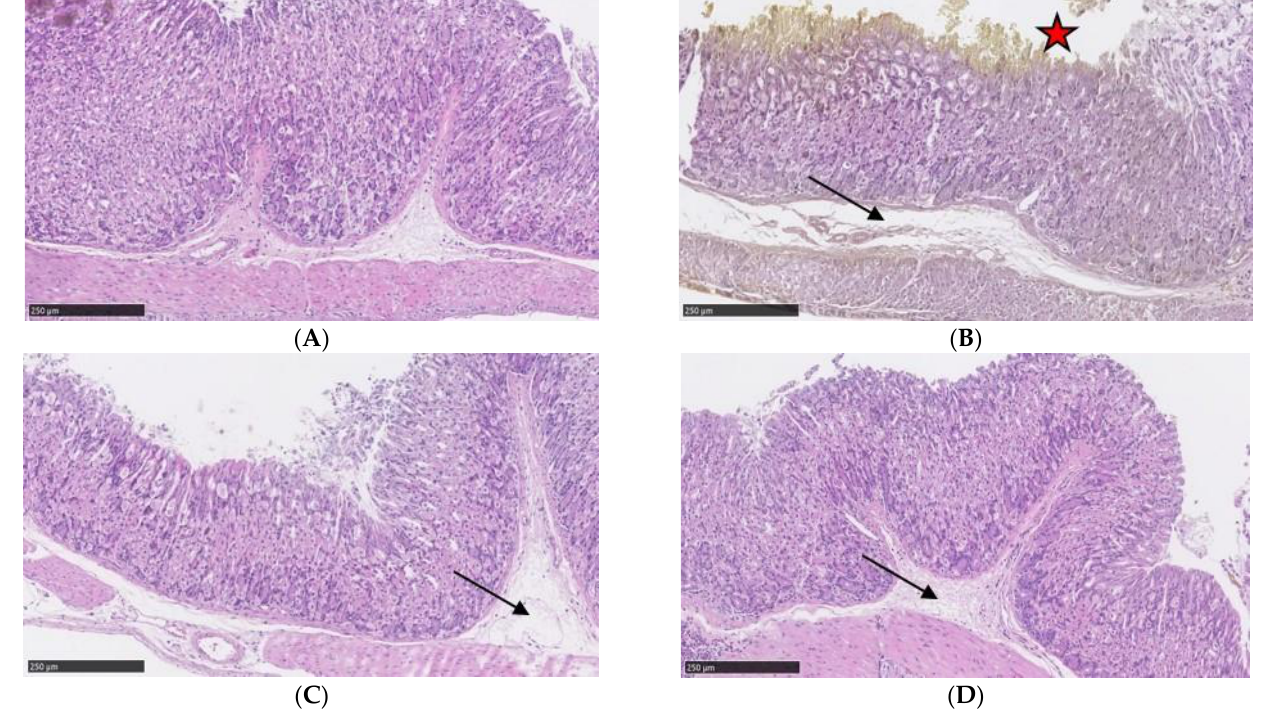
Figure 2. The histopathological assessment of gastric mucosa in mice. (H&E staining, scale bars = 250 μm ). ( A ) Control group; ( B ) IND group, treated with IND (120 mg/kg); ( C ) EEDH200 group, treated with EEDH (200 mg/kg) + IND (120 mg/kg); ( D ) EEDH500 group, treated with EEDH (500 mg/kg) + IND (120 mg/kg). The asterisk showed in the figure indicates the damage of the mucosal epithelium accompanied by the destruction of the gland structure. The arrow showed in the figure depicts edema and inflammatory cell infiltration in the submucosa.